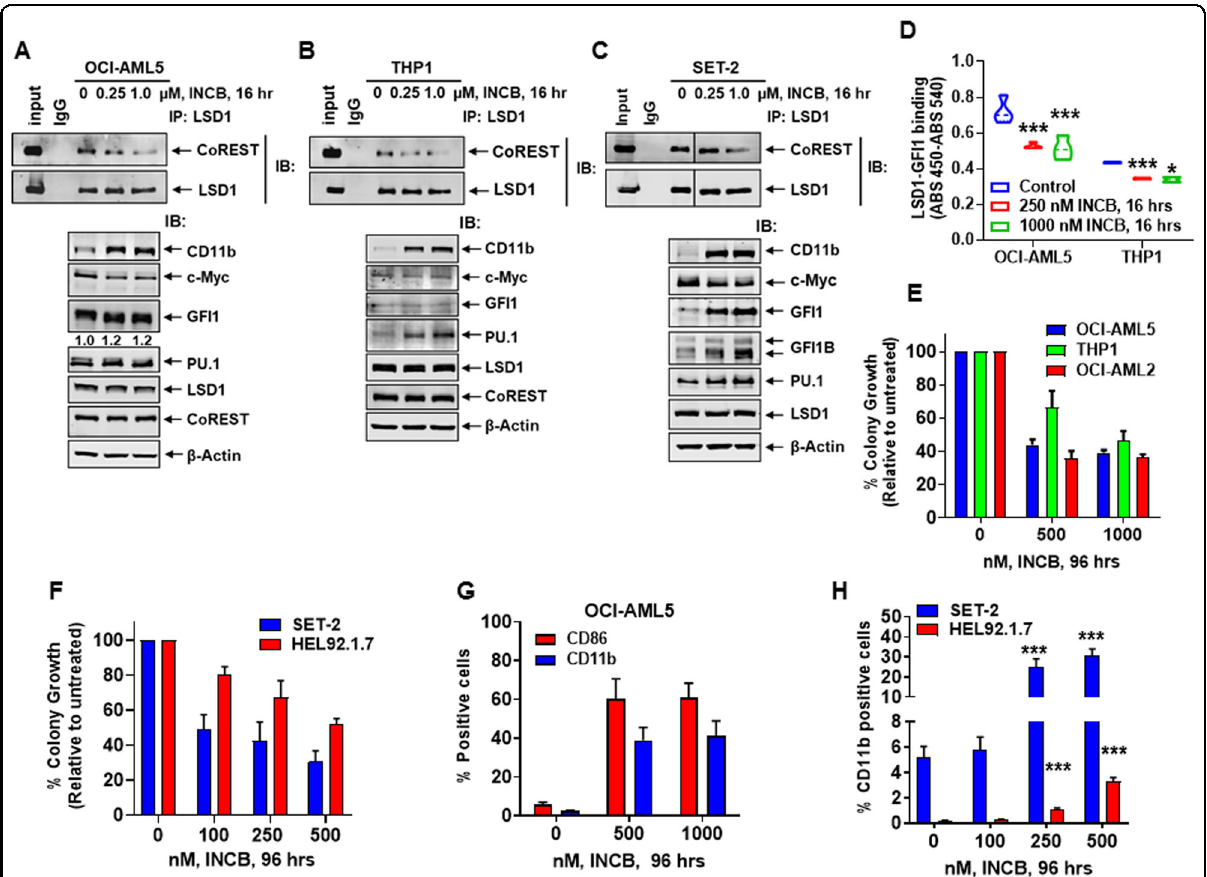
Fig. 3 Treatment with LSD1 inhibitor (LSD1i) disrupts binding of LSD1 to CoREST and GFI1, attenuates colony growth, and induces differentiation in AML cells. A – C Immunoprecipitation and immunoblot analysis of OCI-AML5, THP1, and SET-2 cells treated with INCB059872 for 16 h. D Reduced binding of LSD1 and GFI1 (determined by sandwich ELISA assay) following 16 h of treatment with INCB059872. Mean of two independent experiments performed in duplicate + S.D. * p < 0.05, *** p < 0.005 (determined by a two-tailed, unpaired t -test). E, F OCI-AML5, OCI- AML2, THP1, SET-2, and HEL92.1.7 cells were treated with the indicated concentrations of INCB059872 for 96 h. Then, cells were plated in Methocult media and incubated at 37 °C. Colony growth was assessed after 7 – 10 days. Mean of two independent experiments + S.D. G, H The % of CD86 and/ or CD11b-positive OCI-AML5, SET2 and HEL92.1.7 cells was determined by fl ow cytometry following treatment with INCB059872 for 96 h. Mean of three experiments + S.E.M. *** p < 0.005 in INCB059872-treated cells compared to untreated cells (determined by a two-tailed, unpaired t -test in GraphPad